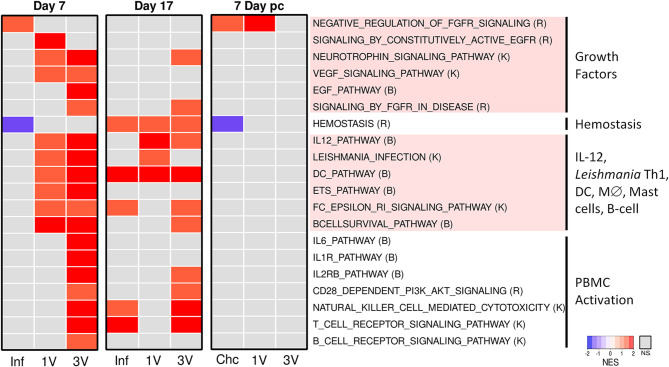
Infection and immunization events induce different gene expression profiles in PBMC. Pathway analysis performed using GSEA (p<0.05) and displayed as heatmaps using the normalized enrichment score (NES) of Inf, 1V and 3V groups at Days 7 and 17 after vaccination/infection and Chc, 1V and 3V groups at Day 7 post-challenge. Data derived from Microarray longitudinal assay➁ with 12–15 mice for experimental groups (Inf, 1V, 3V and Chc), and 22 mice for control group. Four to five biological replicates were assessed per group per time point, in which each individual biological replicate consisted of a pool of PBMCs from three mice (
Supplementary Table 2
). Pathway databases: (R) Reactome, (B) Biocarta, (K) KEGG.